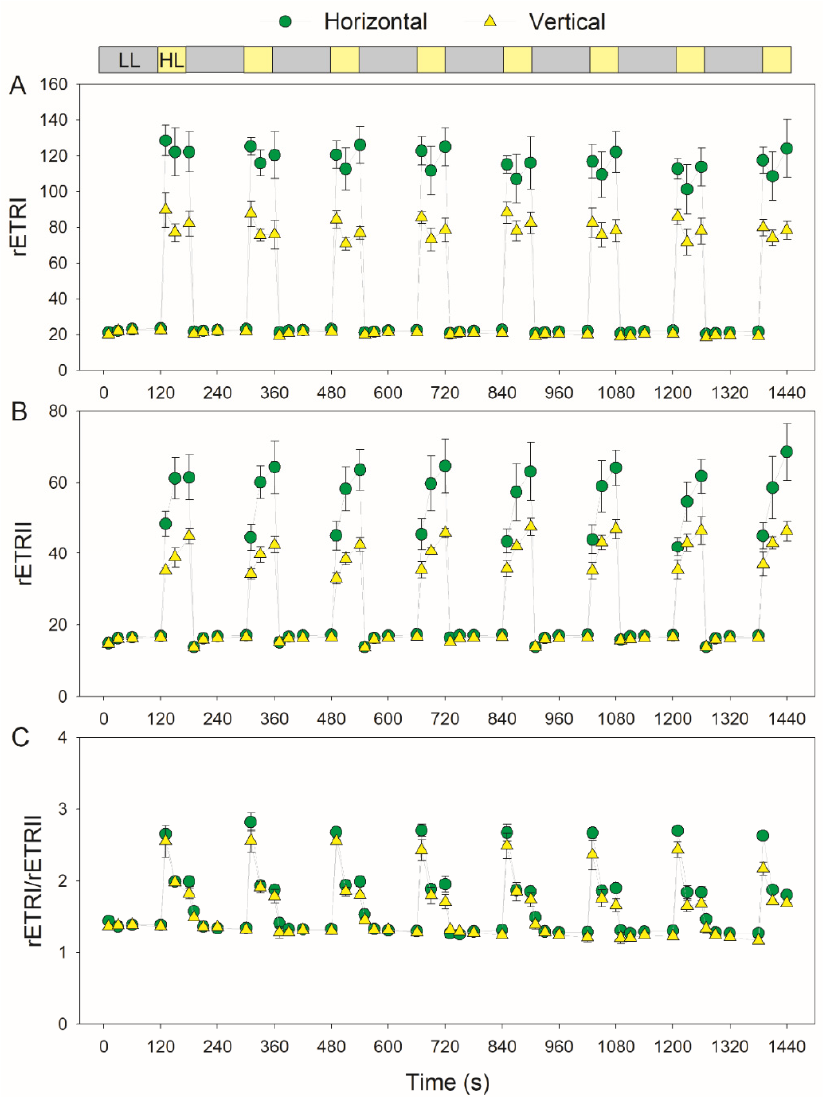
Figure 5. Changes in the relative electron transport rates under fluctuating light in the horizontal (leaf angle = 0 ◦ ) and vertical (leaf angle = 60–65 ◦ ) leaves. After illumination at 1809- µ mol photons m − 2 s − 1 for 20 min for photosynthetic induction, the leaves were exposed to fluctuating light alternating between 59- and 1809- µ mol photons m − 2 s − 1 every 2 min for 24 min. ( A ) rETRI, relative electron transport rate through PSI; ( B ) rETRII, relative electron transport rate through PSII; and ( C ) rETRI/rETRII, relative activation of cyclic electron flow. Data are shown as the means ± SE ( n = 3).